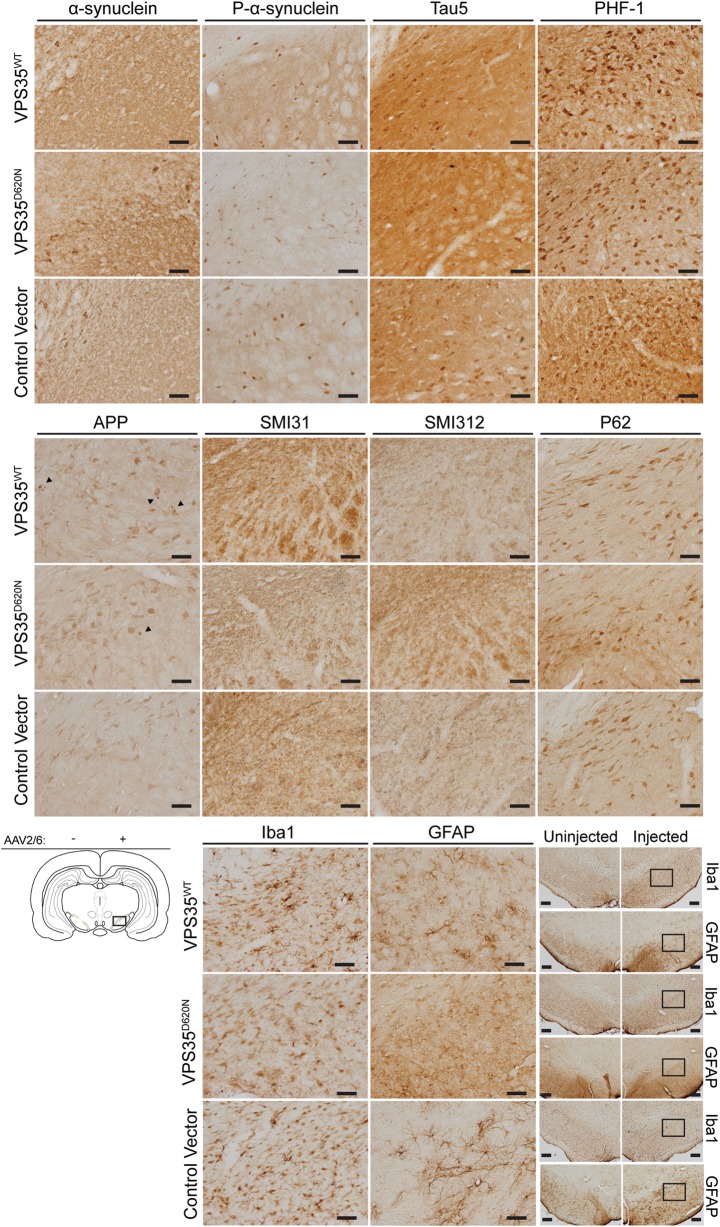
AAV2/6-mediated expression of human VPS35 in the rat substantia nigra induces axonal pathology. Immunohistochemical analysis of substantia nigra at 12 weeks following the stereotactic injection of AAV2/6 vectors expressing human VPS35WT and VPS35D620N or a control vector. Antibodies detecting total α-synuclein, α-synuclein phosphorylated at Ser129 (P-α-synuclein), total tau (Tau5), tau phosphorylated at Ser396 and Ser404 (PHF-1), APP isoforms, phosphorylated neurofilament H (SMI31), phosphorylated neurofilament M/H (SMI312), autophagy substrate p62/sequestosome 1, GFAP and Iba1 were employed. Representative photomicrographs are taken from the injected substantia nigra as indicated in the schematic diagram. Scale bar: 50 μm. Macroscopic images of GFAP and Iba1 in the injected and non-injected substantia nigra are shown for comparison. Boxes indicate the region used for high-power images of the injected substantia nigra. Scale bar: 50 μm.